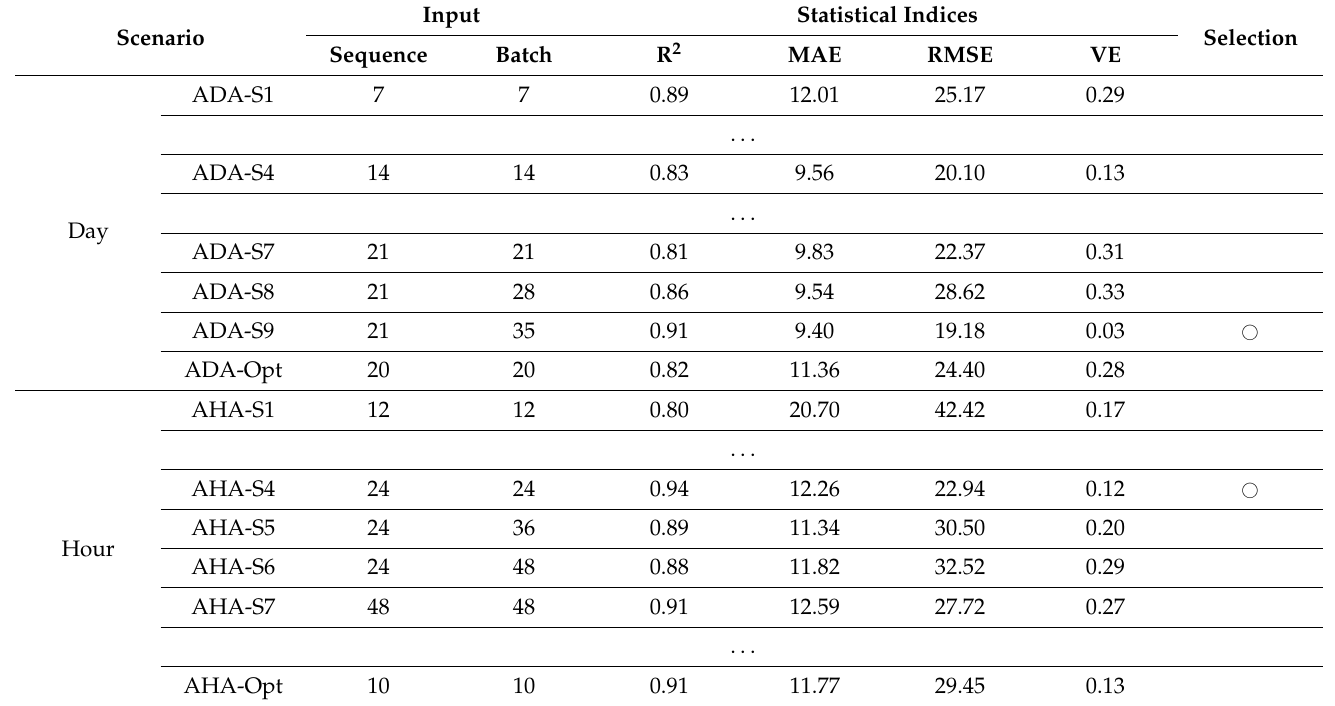
Table 3. Statistical performance by scenario for the ANN at Andong